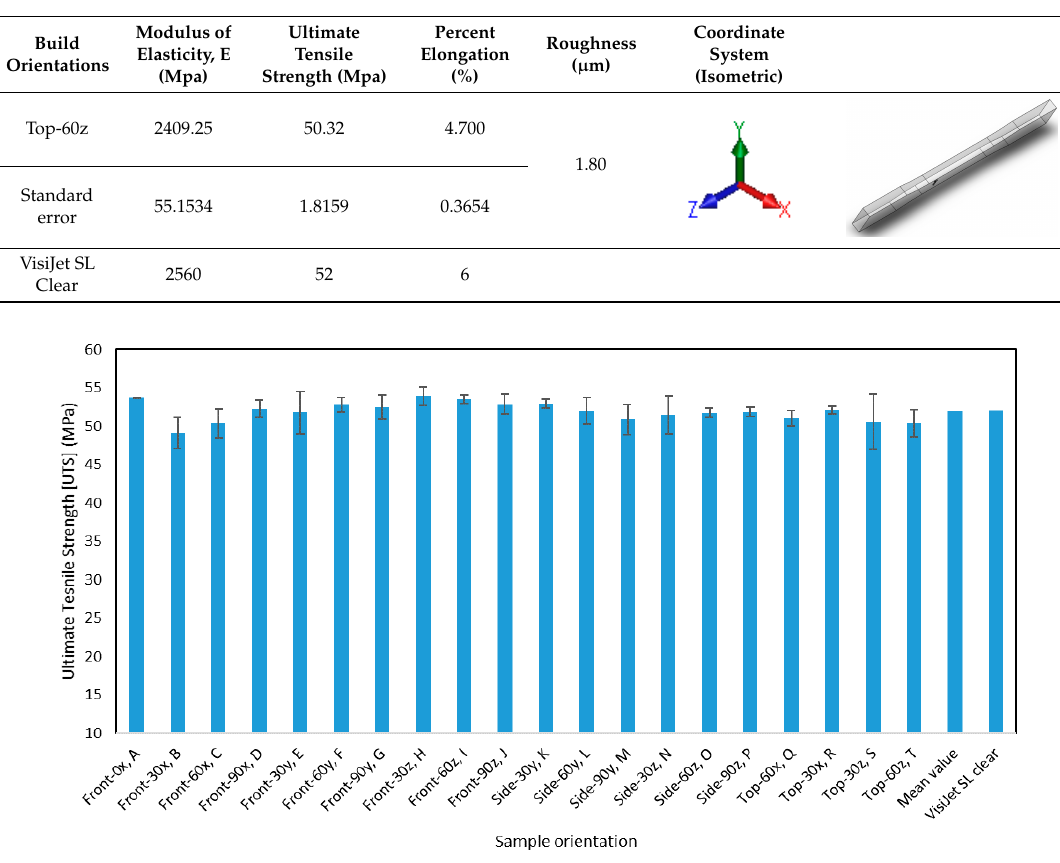
Figure 10. The axial extensometer engaged with a test specimen.